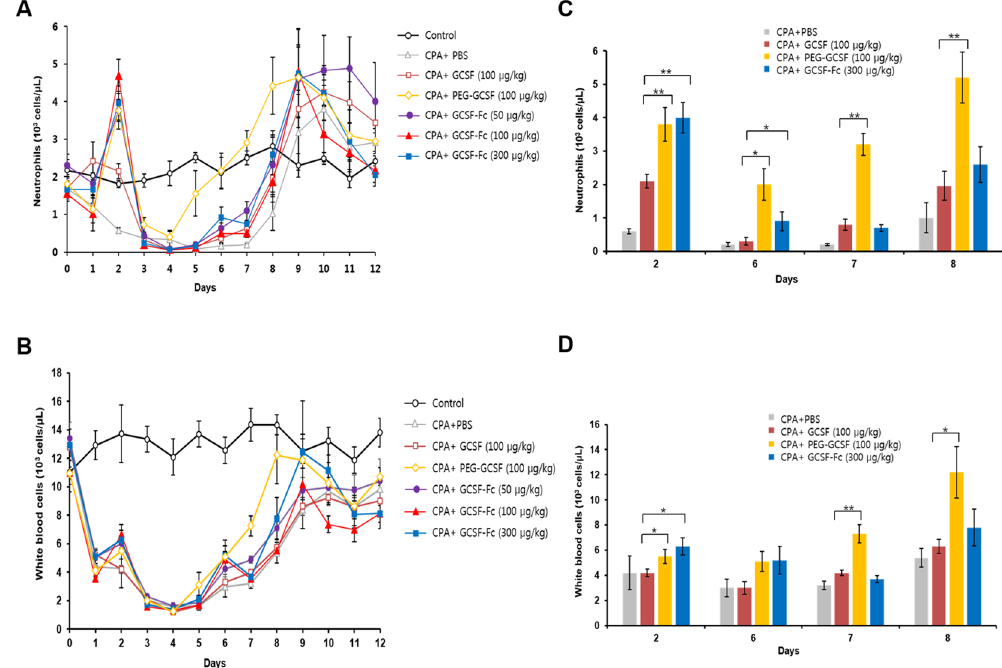
Figure 5. Neutrophils ( A and C ) and white blood cells ( B and D ) counts in neutropenic rats received single injection of GCSF-Fc, PEG-GCSF and GCSF. On day 0, 5 rats in each group but the control group received 100 mg/kg CPA to induce neutropenia. On day 1, neutropenic groups received injections of PBS, GCSF (100 µ g/ kg), PEG-GCSF (100 µ g/kg), or GCSF-Fc (50 µ g/kg, 100 µ g/kg and 300 µ g/kg). Blood samples from the rat groups over 12 days were sent for complete blood count (CBC) analysis. Data are means ± SE of 5 rats/group. Statistical significance compared to GCSF treatment group: * p < 0.05, ** p < 0.01.